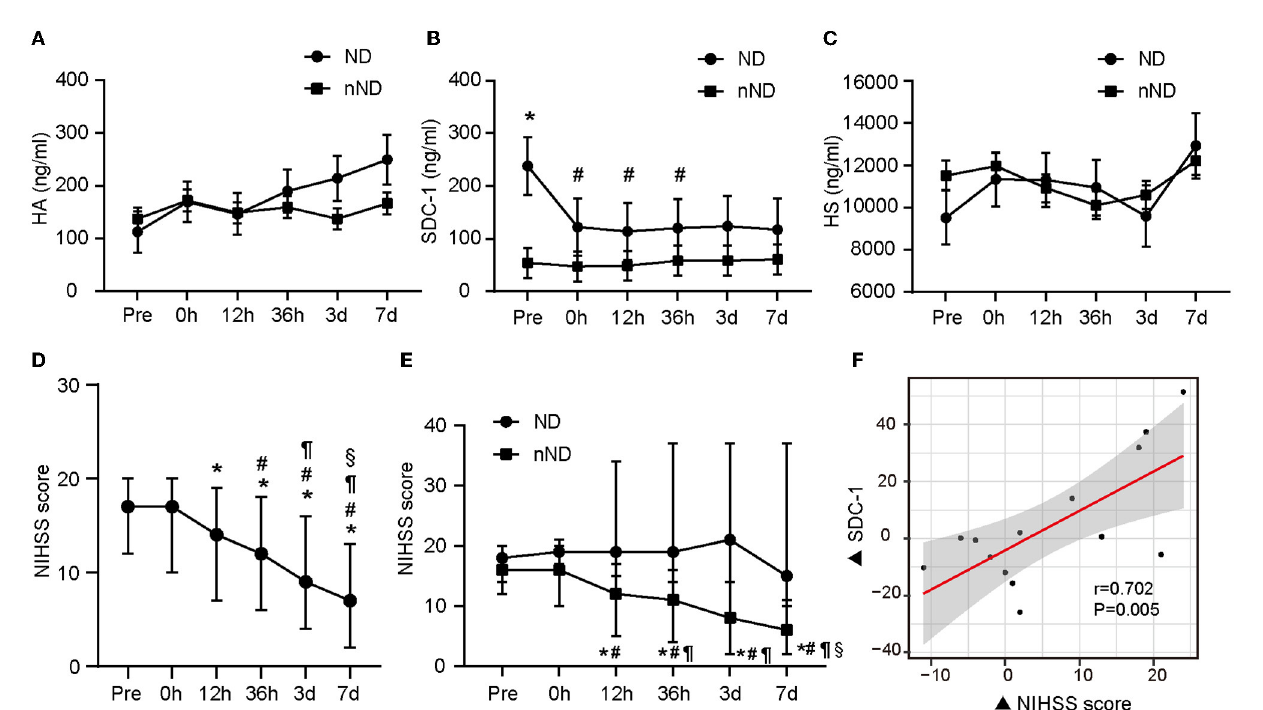
FIGURE2 The glycocalyx components of different evolution and the relationship between glycocalyx and neurological function. The difference in glycocalyx levels between the ND group and the nND group is shown from (A–C) . Neurologic changes in all patients included in the study are presented in (D) . The differences in NIHSS scores between ND and nND groups are shown in (E) . The relationship between the change of NIHSS score and the change of SDC-1 level (based on the level at admission) at 36h after stroke onset is shown in (F) . A linear mixed model was used to compare component concentrations between groups. * p < 0.05 vs. nND and # p < 0.05 vs. pre-operation in (B) respectively. *represents p < 0.05 vs. pre-operation, # represents p < 0.05 vs. 0h after the operation, ¶ represents p < 0.05 vs. 12h after the operation, § represents p < 0.05 vs. 36h after the operation in (D, E) . Significant correlations were tested by Spearman’s rank correlation coefficient. Pre, pre-operation; 0h, 0h after the operation; 12h, 12h after the operation; 36h, 36h after the operation; 3 days, 3 days after the operation; 7 days, 7 days after the operation; ND, neurological deterioration; nND,